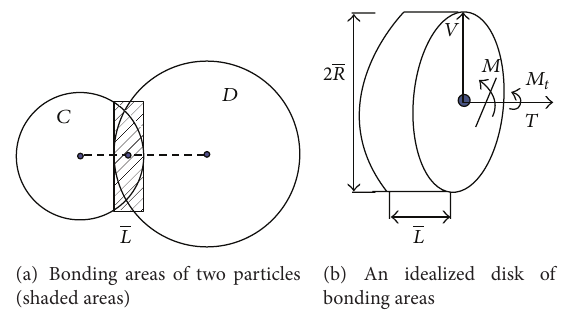
Figure 1: Schematic diagram of parallel